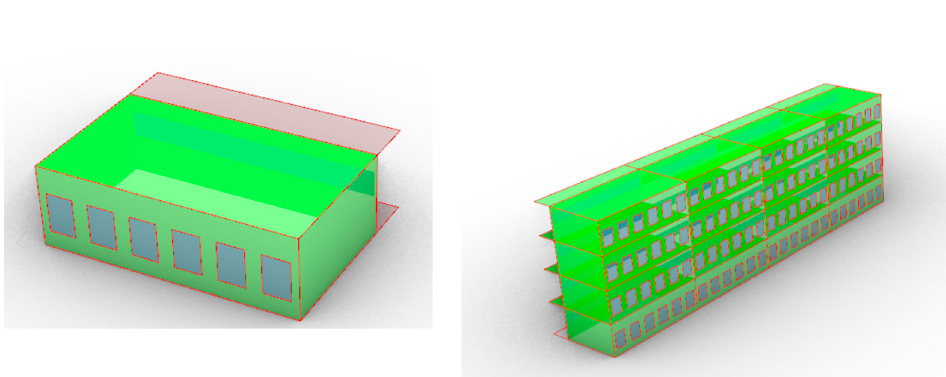
Figure 3. Parametric model of teaching building.